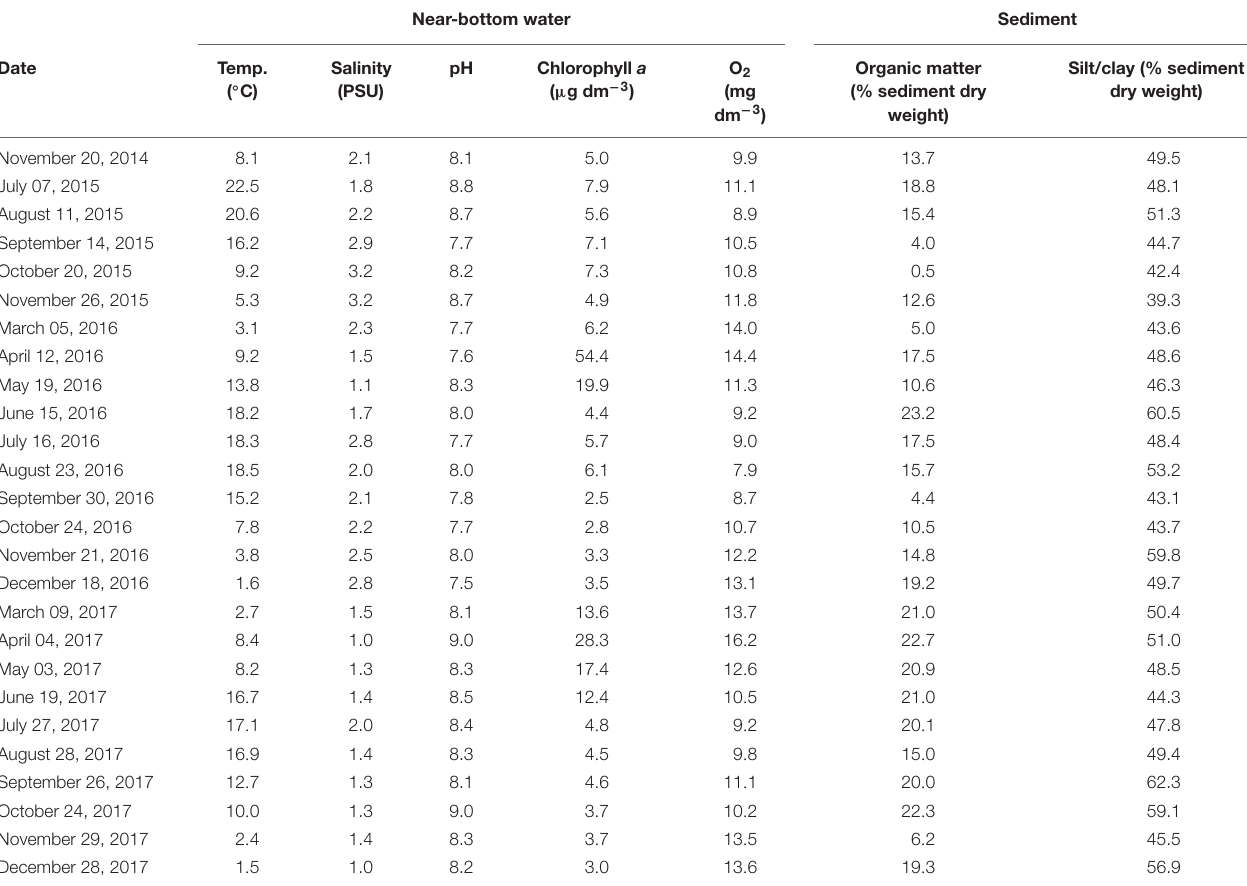
TABLE 1 | Sampling dates and characteristics of the near-bottom water layer (temperature, salinity, pH, chlorophyll a content, dissolved oxygen content) and sediment (organic matter and silt/clay contents) at the Szczecin Lagoon station ZS6 sampled in